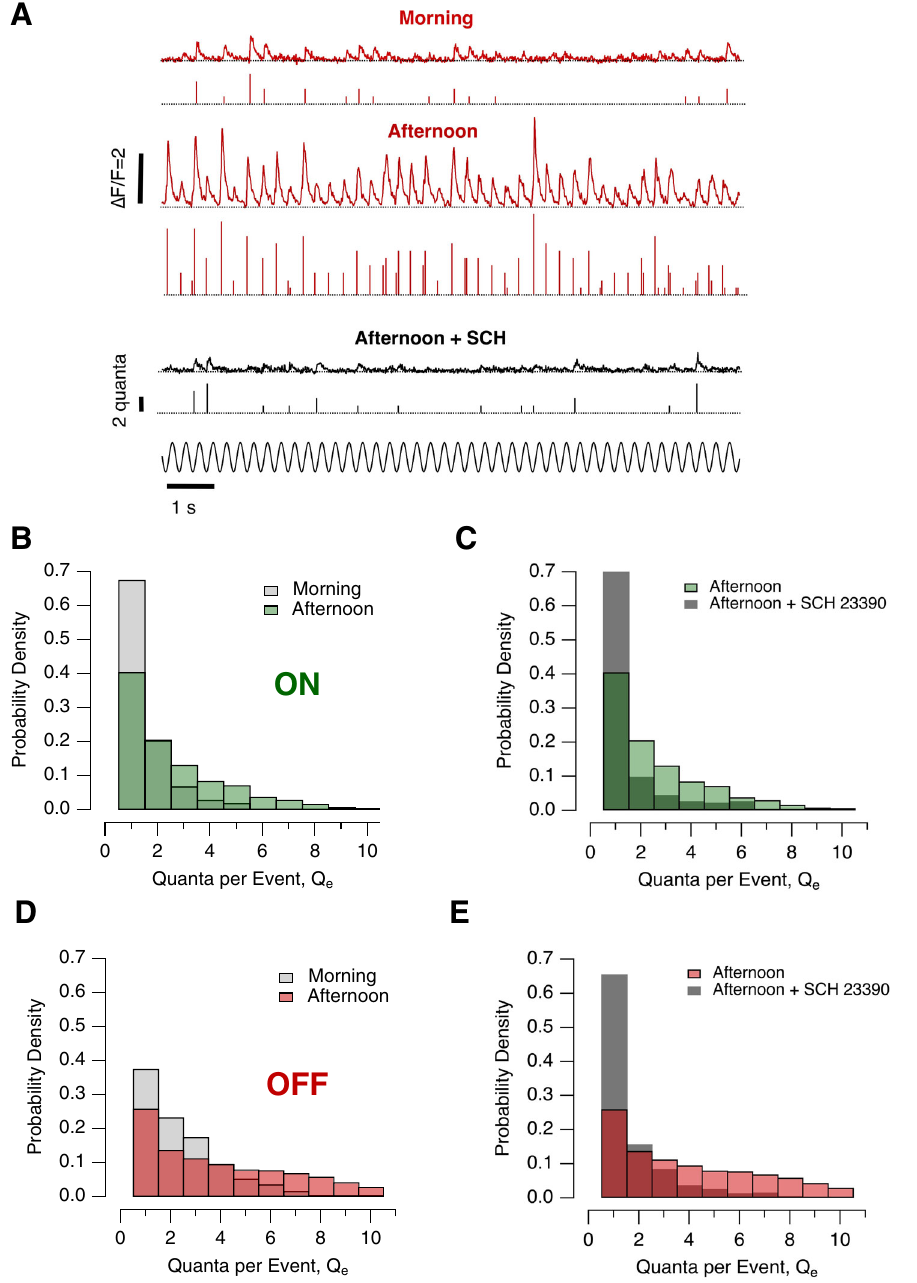
Fig. 7 Dopamine contributes to diurnal variations in the distribution of multivesicular events. A Examples of iGluSnFR signals from individual OFF synapses elicited using 60% contrast stimulus (5 Hz, 30 s) in the morning (top), afternoon (middle) and afternoon + SCH 23390 (bottom). In each case the top trace shows the iGluSnFR signal and the lower trace the estimated Q e. B Changes in Q e in ON synapses in the morning (light grey bars, n = 10 synapses) and afternoon (green bars, n = 14 synapses). In the afternoon the distribution was shifted toward multiquantal events ( p < 0.05, KS-test). C Changes in the distribution of Q e in ON synapses before and after intravitreal injection of the D1 antagonist SCH23390 (dark grey bars, n = 8 synapses). The distribution was shifted toward lower Q e ( p < 0.001) but was not signi fi cantly different to that measured in the morning. D Changes in Q e, in OFF synapses in the morning (light grey bars, n = 19 synapses) and afternoon (red bars, n = 24 synapses). In the afternoon the distribution was shifted toward multiquantal events ( p < 0.02). E Changes in the distribution of Q e in OFF synapses before and after intravitreal injection of SCH 23390 in the afternoon (dark grey bars, n = 12 synapses). The distribution was shifted toward uniquantal events ( p < 0.001). Source data are provided as a Source Data fi comprise the same symbol and the response can be described as events composed of different numbers of vesicles were considered the number of spikes in each of a series of time bins 24,40 . The different symbols for the conveying of information 23,41 . The output from bipolar cells is qualitatively different with a visual mutual information between the response and stimulus was then stimulus being encoded both by the timing of release events and computed as the average amount of information about the sti- their amplitudes 19 . We therefore took an approach in which MVR mulus gained from observing any symbol (see Methods).